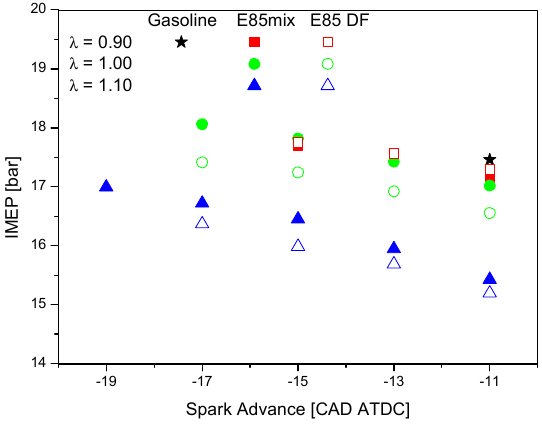
Figure 3. Indicated mean effective pressure against SA at different λ .